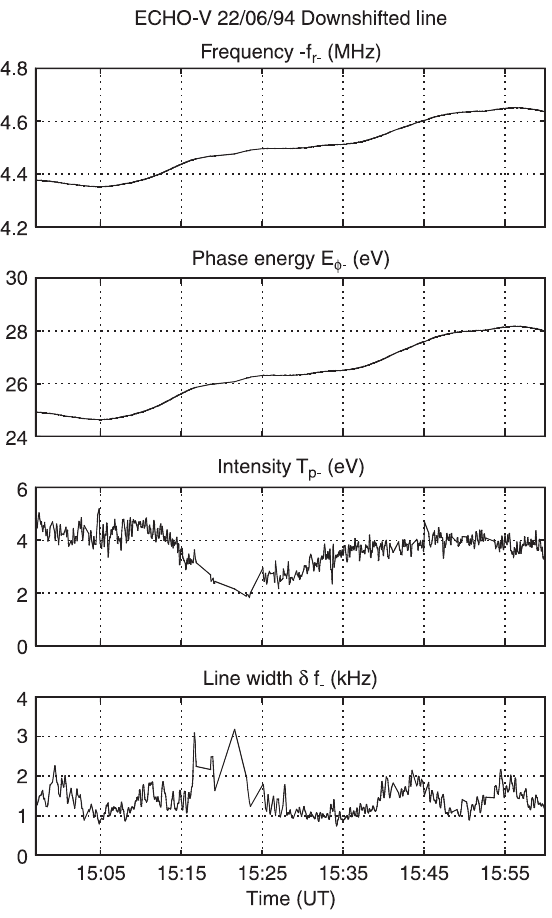
Fig. 3. The parameters extracted from the downshifted plasma line analysis for the 1-h period of observation. From top to bottom : the absolute value of the critical frequency j f r (cid:255) j , the corresponding phase energy E / (cid:255) , the intensity of the line (or plasma line temperature) T p (cid:255) and the line width d f